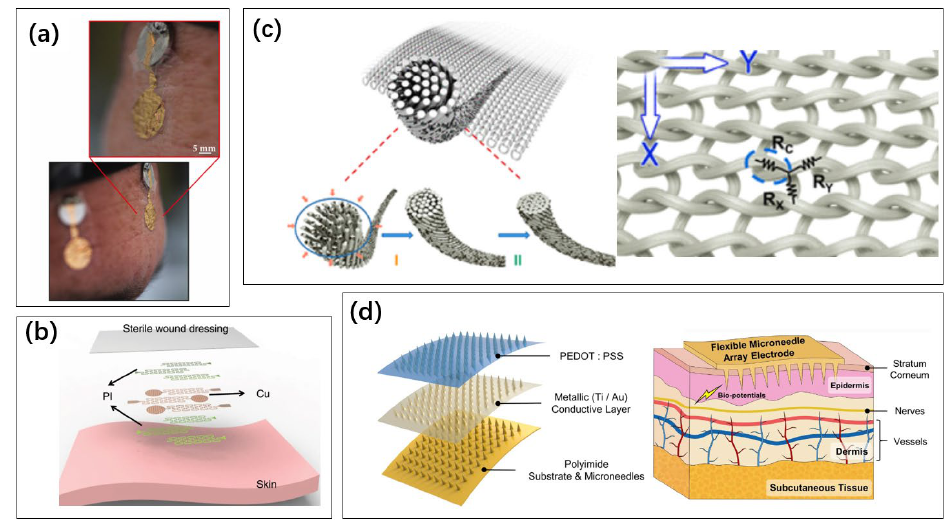
Figure 8. Method for collecting electrical signals on the skin’s surface: ( a ) gold electronic tattoo [99].